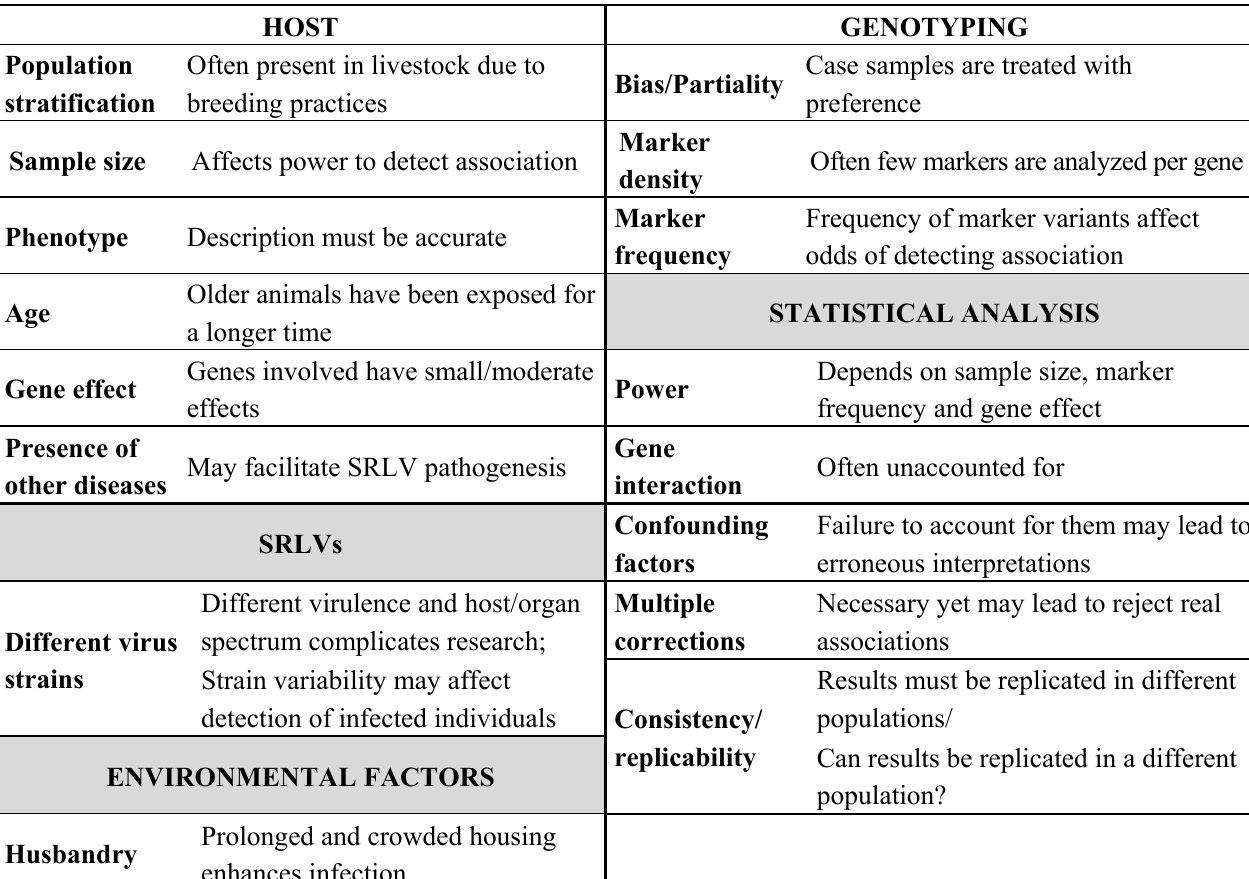
Table 1. Limitations of genetic association studies in complex multifactorial diseases such as SRLV-induced pathologies. Factors leading to confounding that may be encountered as well as their consequences are shown (information compiled from